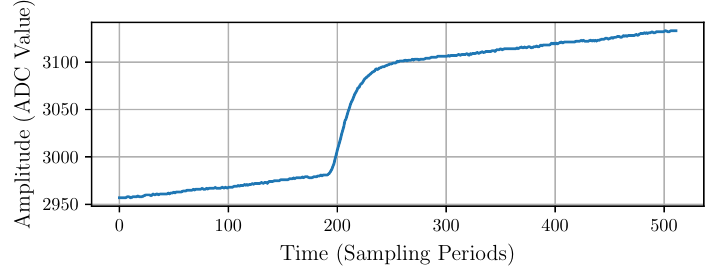
Figure 2. Typical experimental single-photon pulse at the output of the charge-sensitive ampli- fier